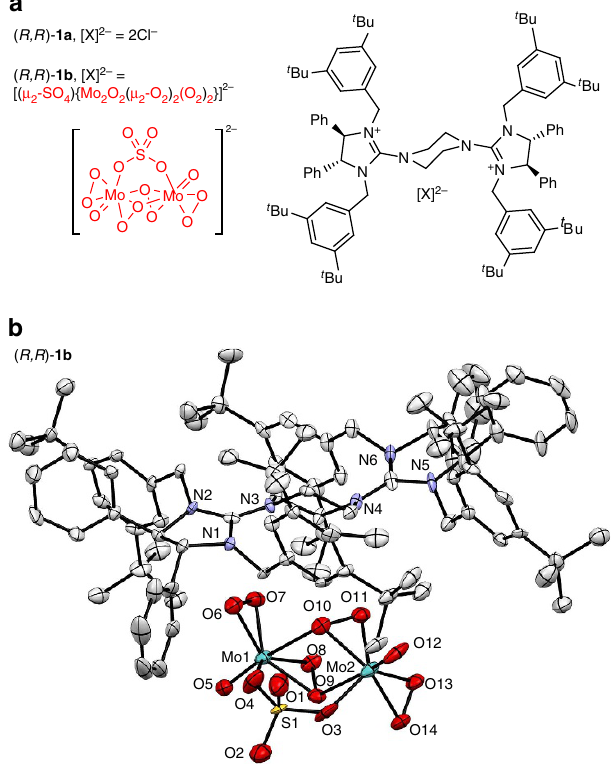
Figure 2 | Bisguanidinium ion pairs ( R , R )-1a and ( R,R )-1b. ( a ) Structure of bisguanidinium salts. ( b ) X-ray crystallographic structure of [ BG ] 2